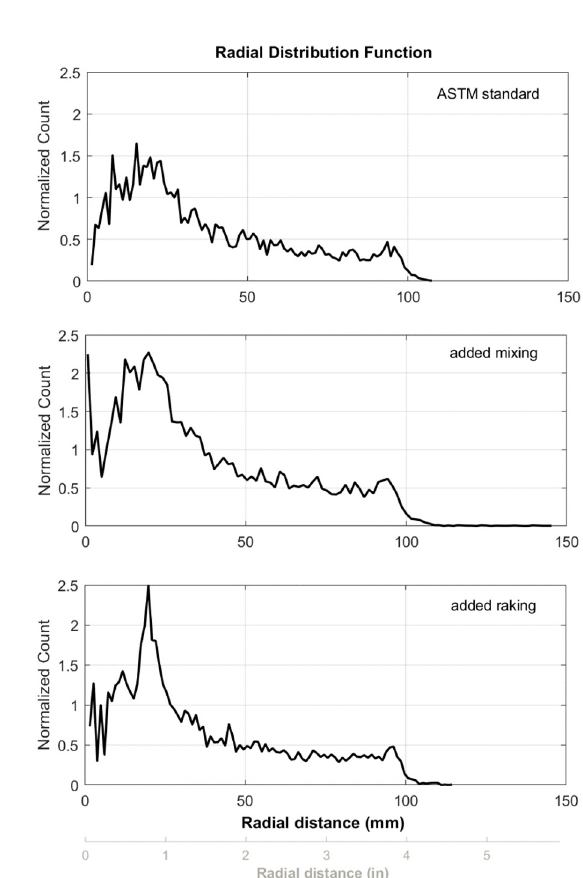
Figure 8. Radial distribution statistics of the coarse aggregate identified in the 3 XCT scanned volumes for each casting method. On average 6,300 aggregate centroid positions in 3D space were used to generate each